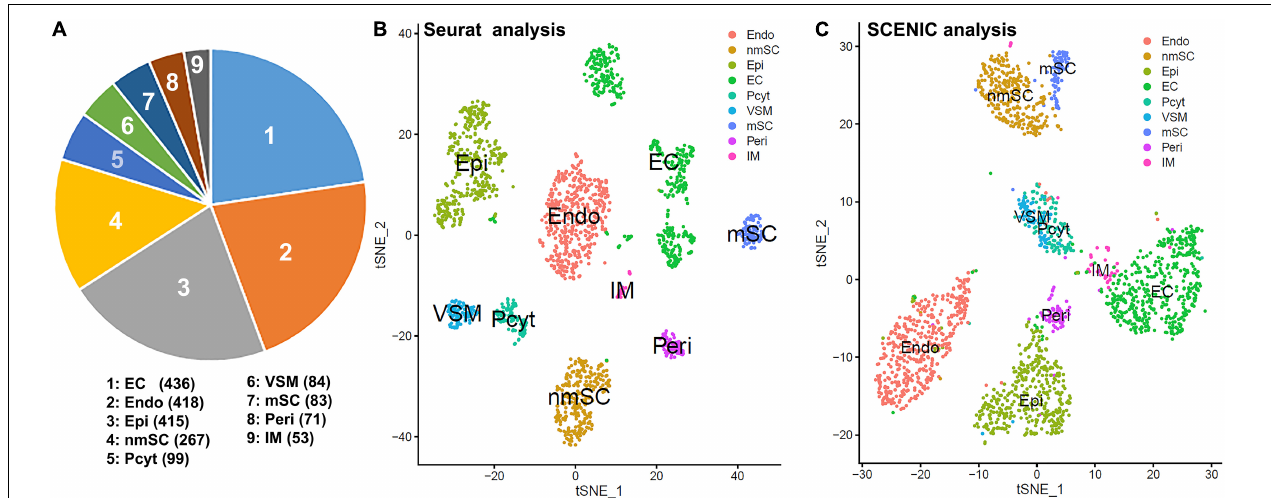
FIGURE 1 | Single-cell transcriptomics defines cellular phenotypes in intact mouse sciatic nerve by both Seurat and single-cell regulatory network inference and clustering (SCENIC) analysis using scRNA-seq data set GSE147285. (A) Cell number for endothelial cells (ECs), endoneurial (Endo), perineurial (Peri), and epineurial (Epi) fibroblasts, myelinating Schwann cells (mSCs), and non-myelinating Schwann cells (nmSCs), vascular smooth muscle (VSM) cells, pericytes (Pcyt), and immune (IM) cells. (B) T-distributed stochastic neighbor embedding (tSNE) visualization of cell clusters in intact mouse sciatic nerve following Seurat analysis; nine cell clusters have been identified in this analysis based on gene expression. (C) The tSNE visualization of transcription factor (TF) regulon activity in intact mouse sciatic nerve following SCENIC re-analysis. Cell types are annotated using the Seurat clustering from gene expression.